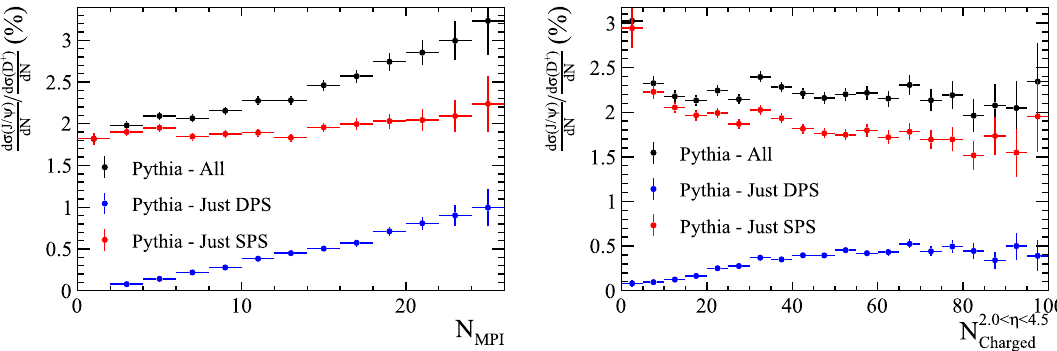
Fig. 16 Ratio of differential cross-section of J / ψ and D + hadrons as a function of (left) the number of parton interactions in a collision and (right) the number of charged particles within the pseudo-rapidity region 2 . 0 < η < 4 . 5, as generated with